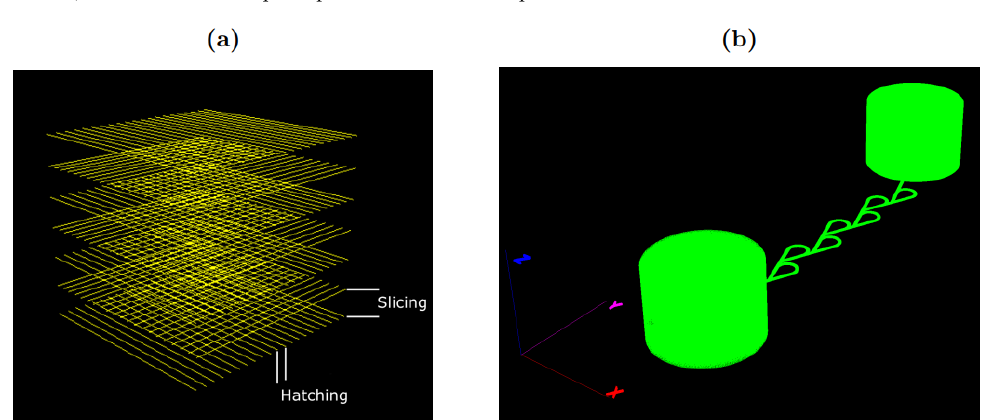
Figure 4. ( a ) sliced/hatched cube in 3DPoli software for a better explanation of parameters, since they are crucial for high-quality structure manufacturing; ( b ) processed Tesla valve 3D model and ready to be fabricated. Green-colored figures indicate a laser path with a shutter turned